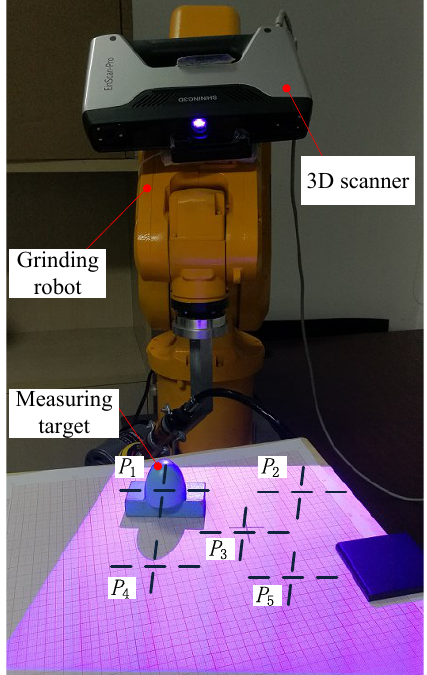
Figure 3. Experimental scenario for measuring the measurement accuracy of the 3D vision